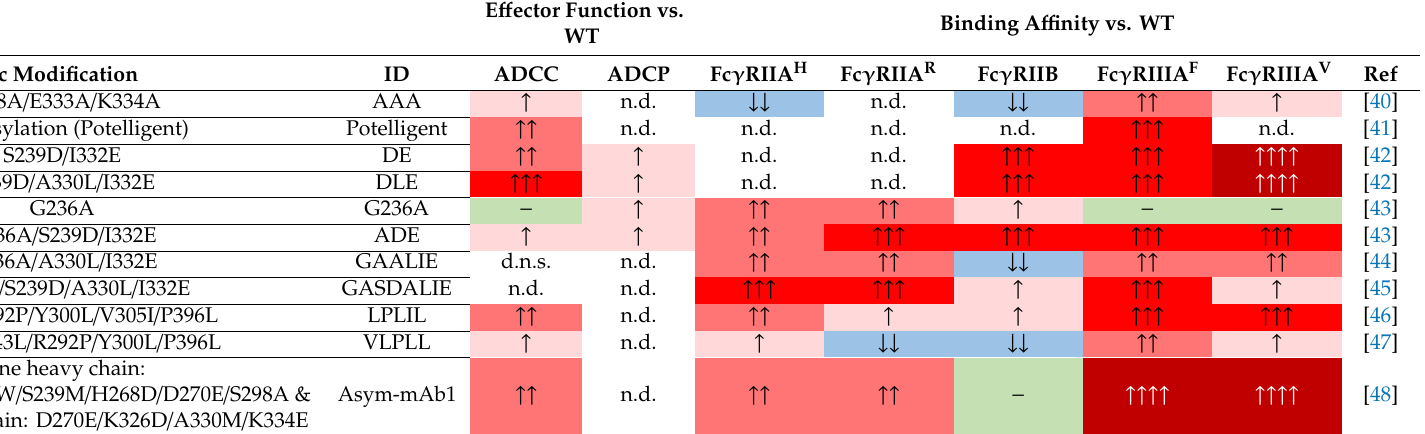
Table 1. Mutations augmenting cellular e ff ector function and Fc γ R binding. E ff ector Function